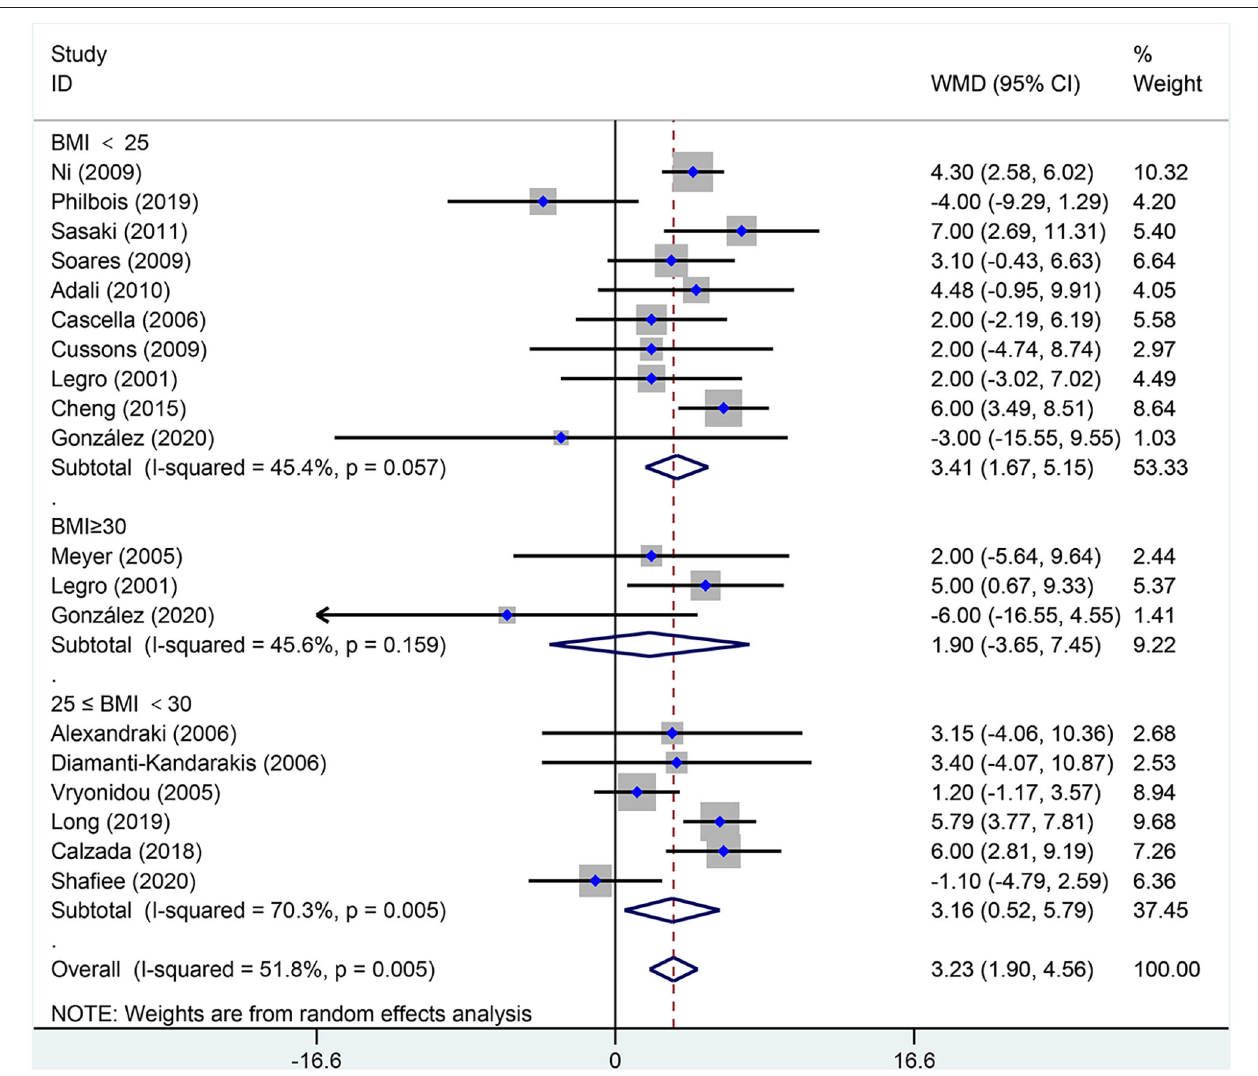
FIGURE 6 | Forest plot for comparison of systolic blood pressure in polycystic ovary syndrome vs. control subjects. Studies are classified by different body mass index (BMI) categories (BMI < 25 kg/m 2 , BMI ≥ 30 kg/m 2 , and BMI 25–30 kg/m 2